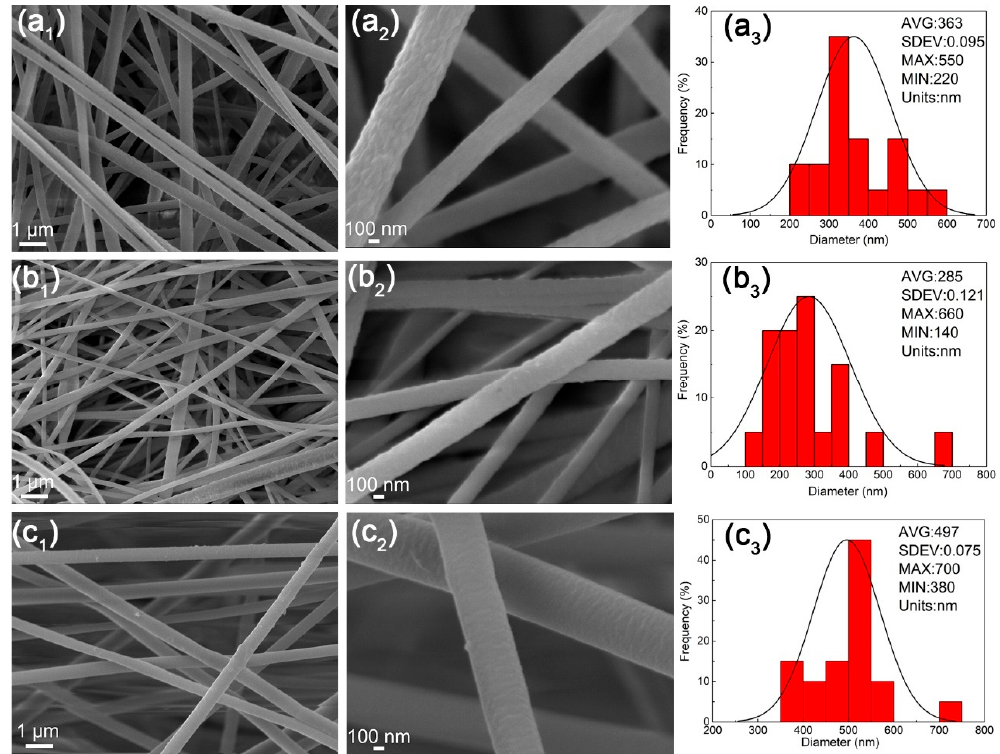
Figure 2. Representative scanning electron microscopy (SEM) images of ( a 1 – a 2 ) PAN, ( b 1 – b 2 ) P(AN-co-IA), and ( c 1 – c 2 ) P(AN-co-AMPS) nanofibers with different scales. ( a 3 ), ( b 3 ), and ( c 3 ) are diameter distribution histograms corresponding to PAN, P(AN-co-IA), and P(AN-co-AMPS) nanofibers, respectively.